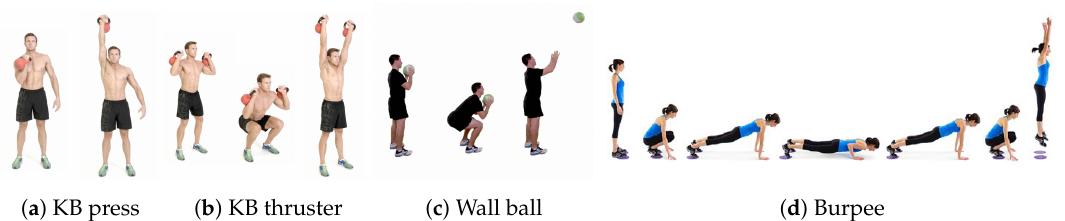
Figure 1. Execution of four typical CrossFit exercises. In our setting, the kettlebell (KB) thruster ( b ) is performed with only the right hand.